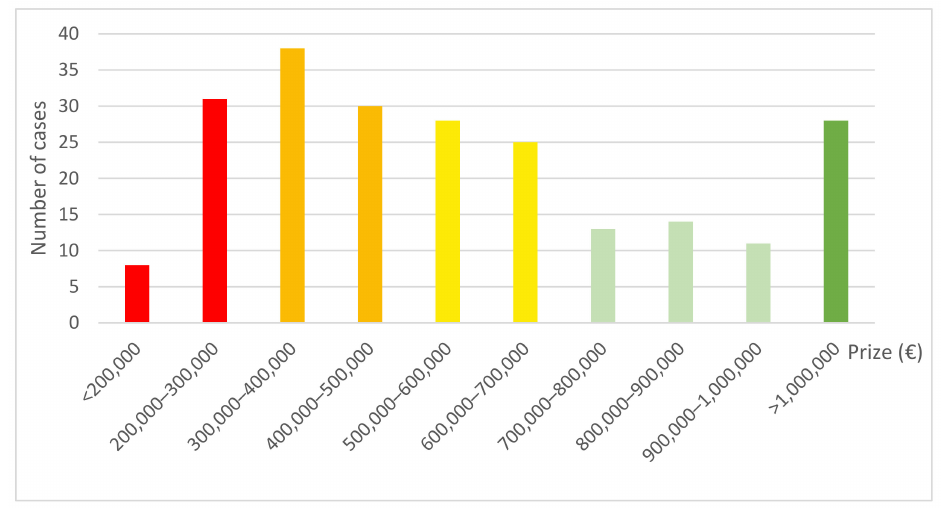
Figure 11. Histogram of the prices in the sample (own elaboration).